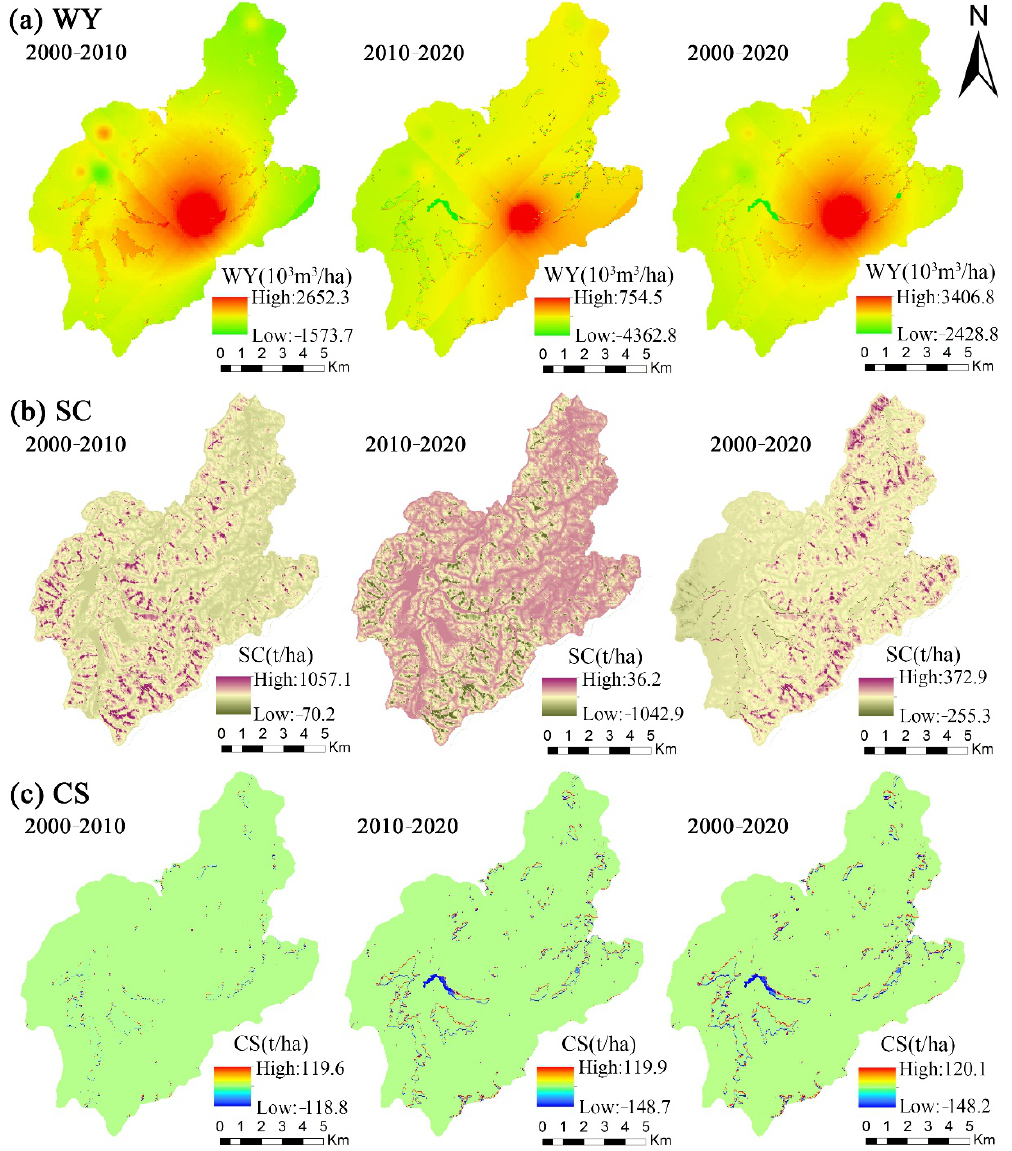
Figure 5. Spatial and temporal variation in ecosystem services in the study area from 2000 to 2010, 2010 to 2020, and 2000 to 2020; ( a ) water yield; ( b ) soil conservation; ( c ) carbon sequestration.